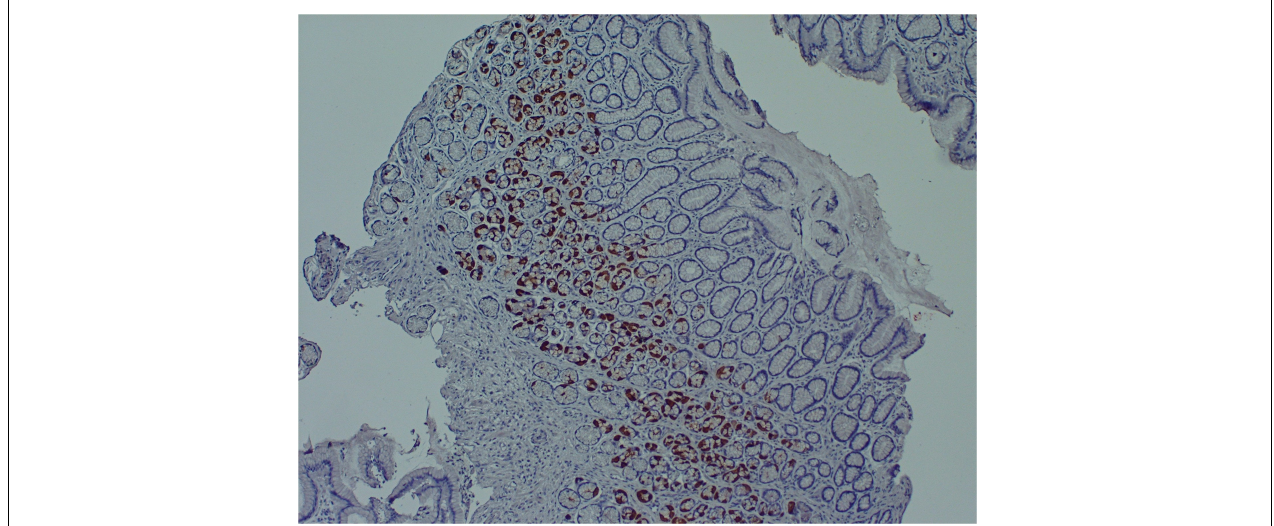
FIGURE 2 | Enteroviral capsid protein 1 in the stomach biopsy of an ME/CFS patient by immunoperoxidase staining (100 × ) (Chia et al., 2015). This type of chronic viral infection is difficult to identify without the use of special techniques such as antibody staining or nucleic acid amplification of biopsies taken from symptomatic areas, since viral cultures are rarely positive. Original image courtesy of Dr. John